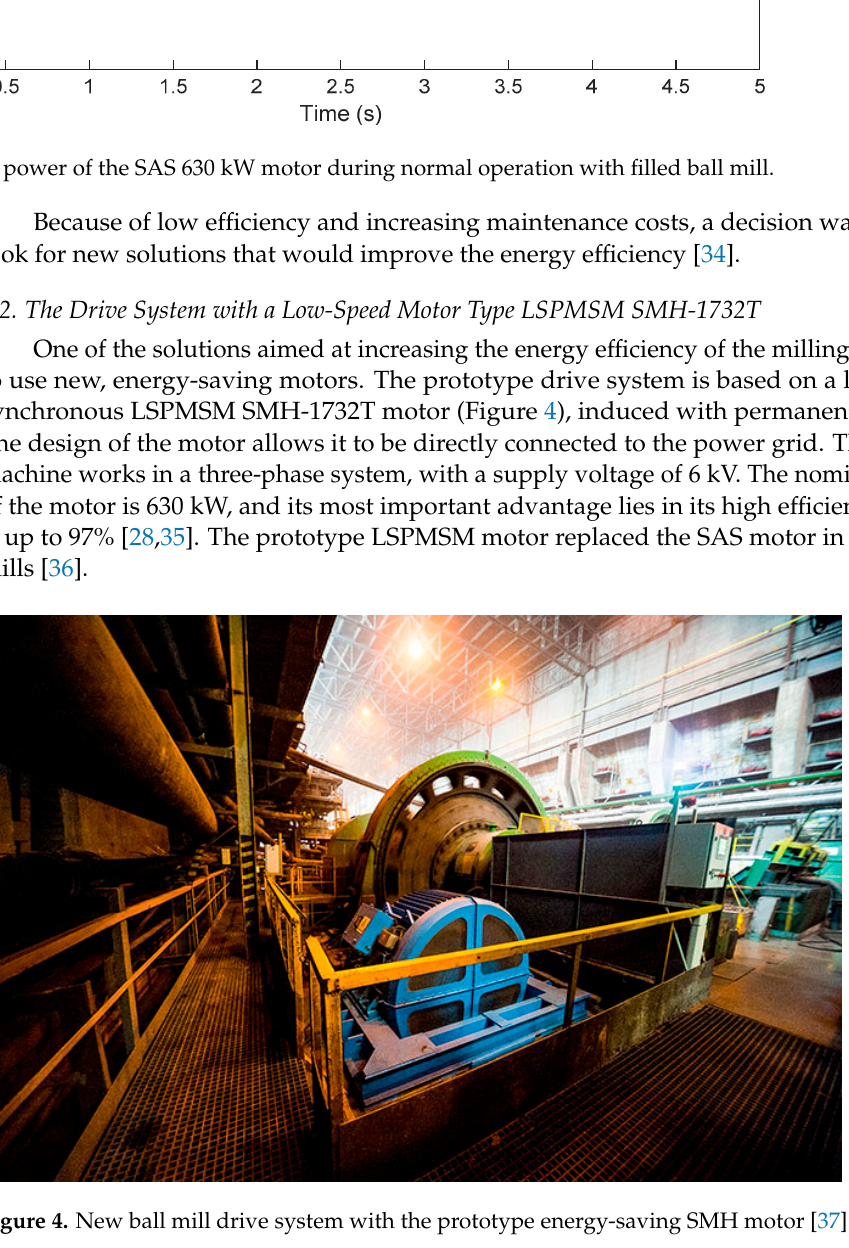
Figure 5. Start-up of the LSPMSM SMH-1732T motor with a filled ball mill after two hours of downtime: ( a ) active power, ( b ) current intensity, ( c ) voltage. The start-up of the new motor lasts for approximately 2 s (Figure 5). Immediately after the motor starts, its instantaneous active power reaches the peak value of 3500 kW, being more than 5-fold in excess of its nominal power (Figure 5a). The start-up also entails significant changes of current intensity in the windings of the motor (Figure 5b). The high- 0